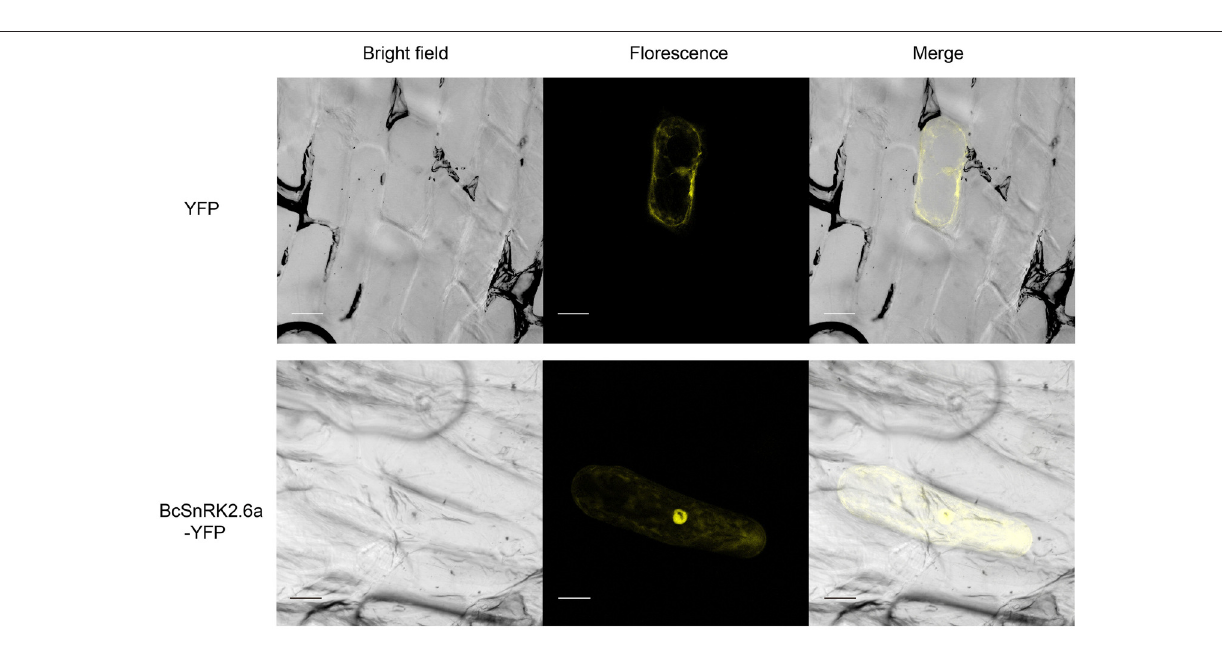
FIGURE 6 | Subcellular localization analysis of SnRK2.6a. The subcellular localization analysis of the putative BcSnRK2.6a protein. The upper panel, the corresponding bright field, fluorescence, merged fluorescence image of YFP control; the lower panel, the corresponding bright field, fluorescence, merged fluorescence image of BcS2.6a-YFP. Scale bars: 20 µ